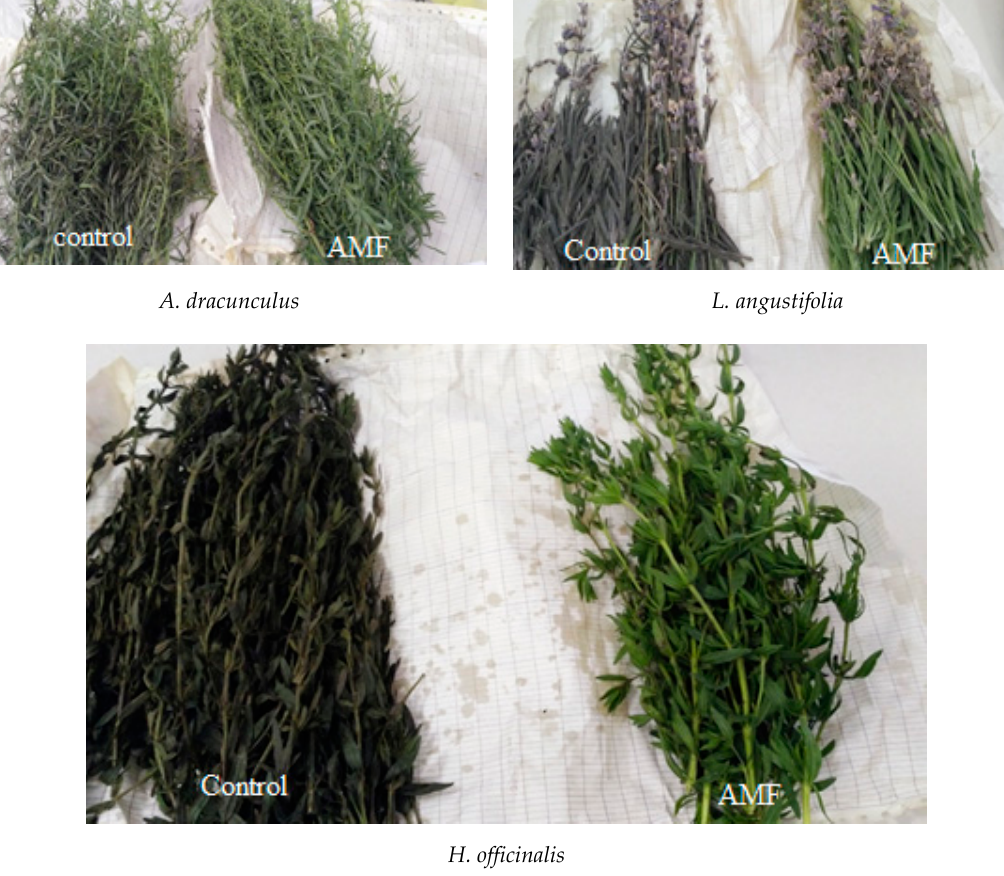
ff ect of AMF application on aromatic plant tolerance to abiotic Figure 2. Effect of AMF application on aromatic plant tolerance to abiotic stress. Figure 2. E